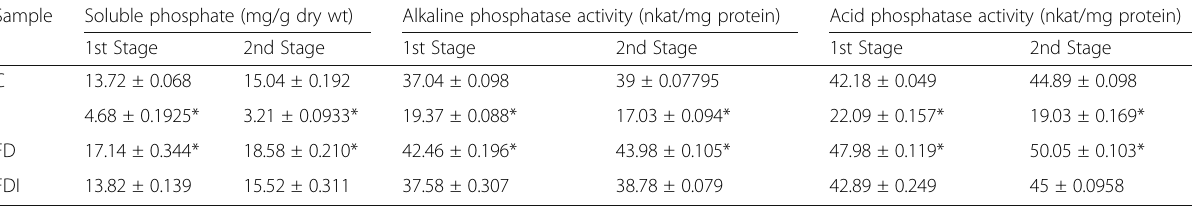
Table 3 Effect of defensin priming on organic phosphate hydrolysis (soluble phosphate and acid and alkaline phosphatases activity) in plants under Fusarium